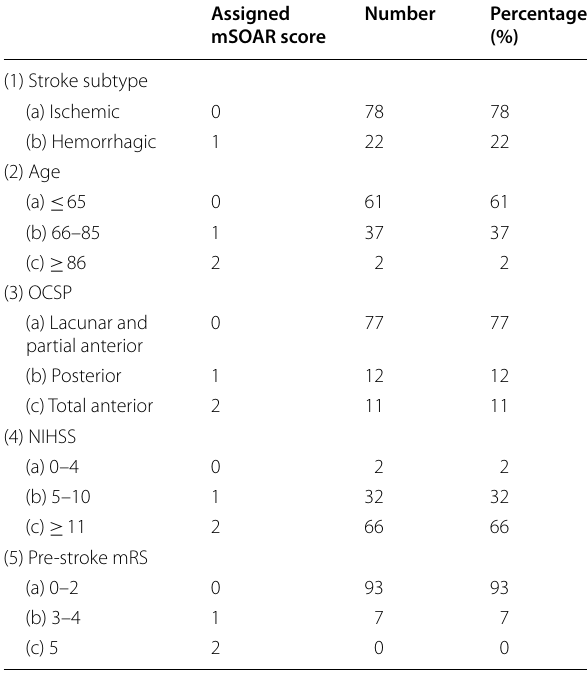
Table 4 Prediction of moderate-severe discharge disability